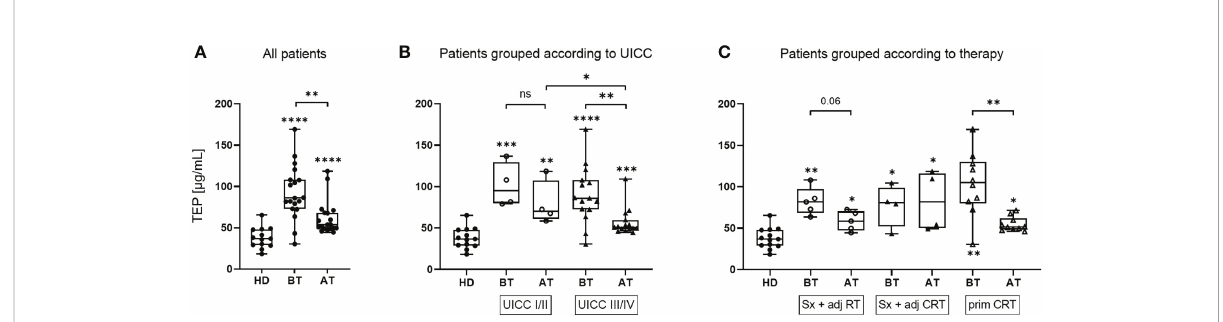
FIGURE 1 TEP values of exosomes isolated from plasma of HNSCC patients before and after therapy. Total exosome protein (TEP) concentrations of the exosome fraction obtained from plasma of n = 13 healthy donors (HD) and n = 19 head and neck squamous cell carcinoma (HNSCC) patients before therapy (BT) and after therapy (AT). Results are shown ungrouped (A) or grouped according to Union for International Cancer Control (UICC) stage (B) or therapy regiment (C) , as indicated in the text boxes. N = 4 HNSCC patients were UICC I/II and n = 15 were UICC III/IV. N = 5 HNSCC patients were treated with surgery + adjuvant radiotherapy (Sx + adj RT), n = 4 with surgery and adjuvant chemoradiotherapy (Sx + adj CRT) and n = 10 with primary chemoradiotherapy (prim CRT). Results are plotted as box-and-whisker blots representing the median value, the 25th and 75th quartiles and the range. Wilcoxon related samples tests were applied to compare BT and AT. Mann-Whitney test was applied to compare HD with each BT or AT. *, **, *** and **** correspond to p ≤ 0.05, p ≤ 0.01, p ≤ 0.001 and p ≤ 0.0001, respectively. ns, not signi fi cant. Asterisks above boxes indicate the signi fi cance compared to